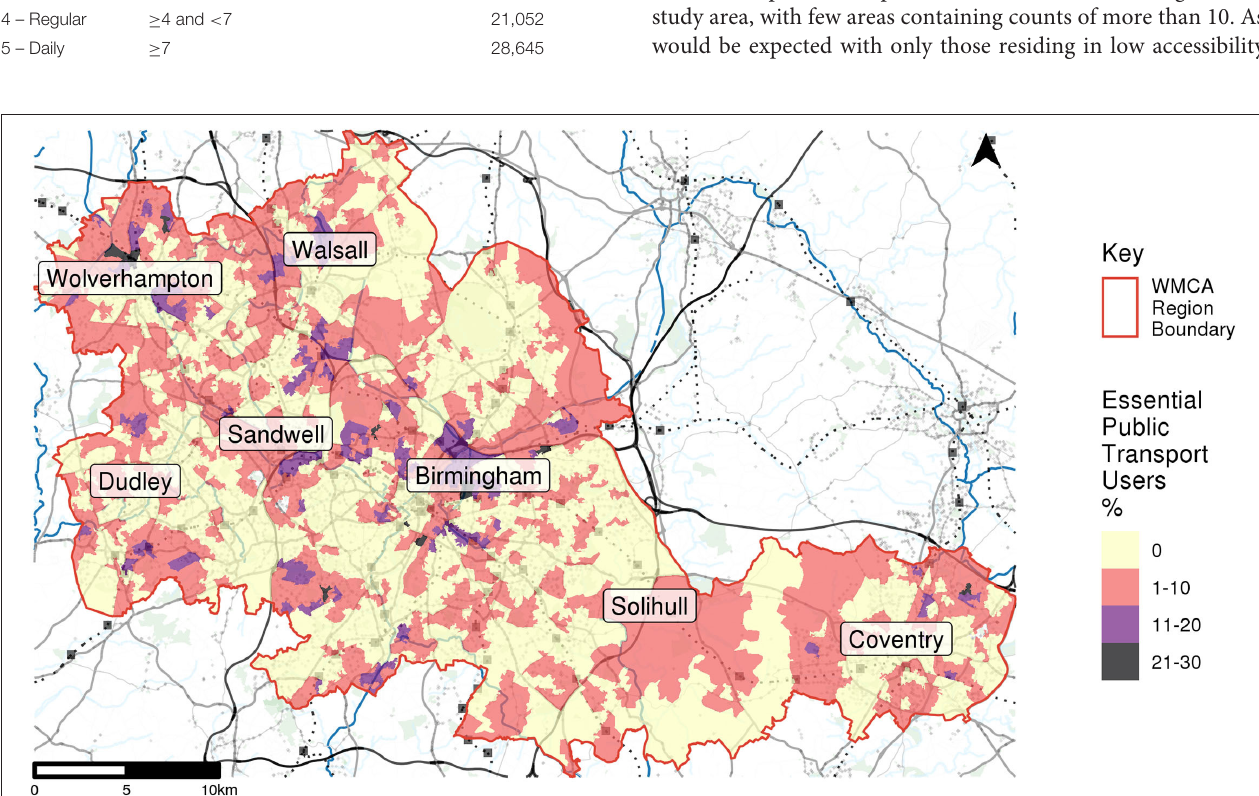
FIGURE 5 | Number of access deprived transit users at LSOA